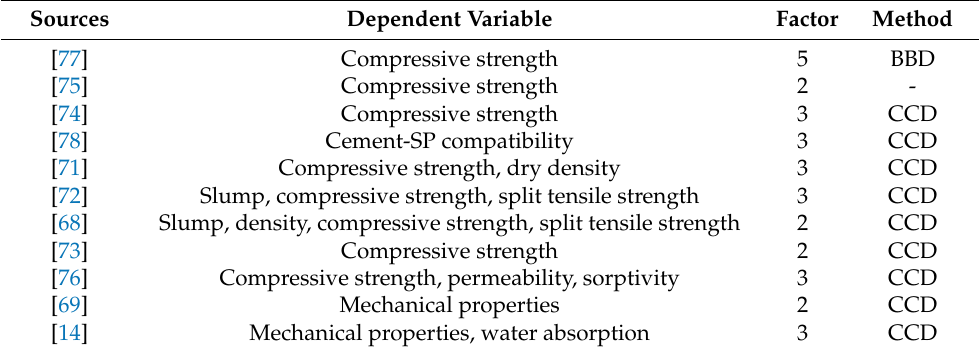
Table 8. Summary of the RSM studies.